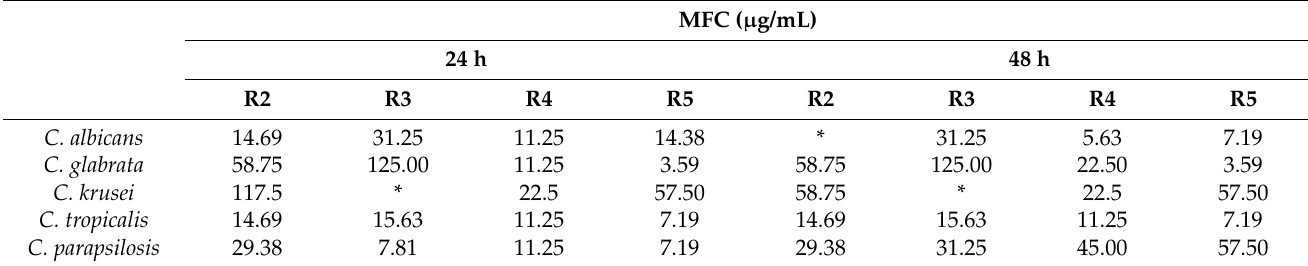
Table 7. MFC values ( µ g/mL) of the sub-fractions R2 to R5.